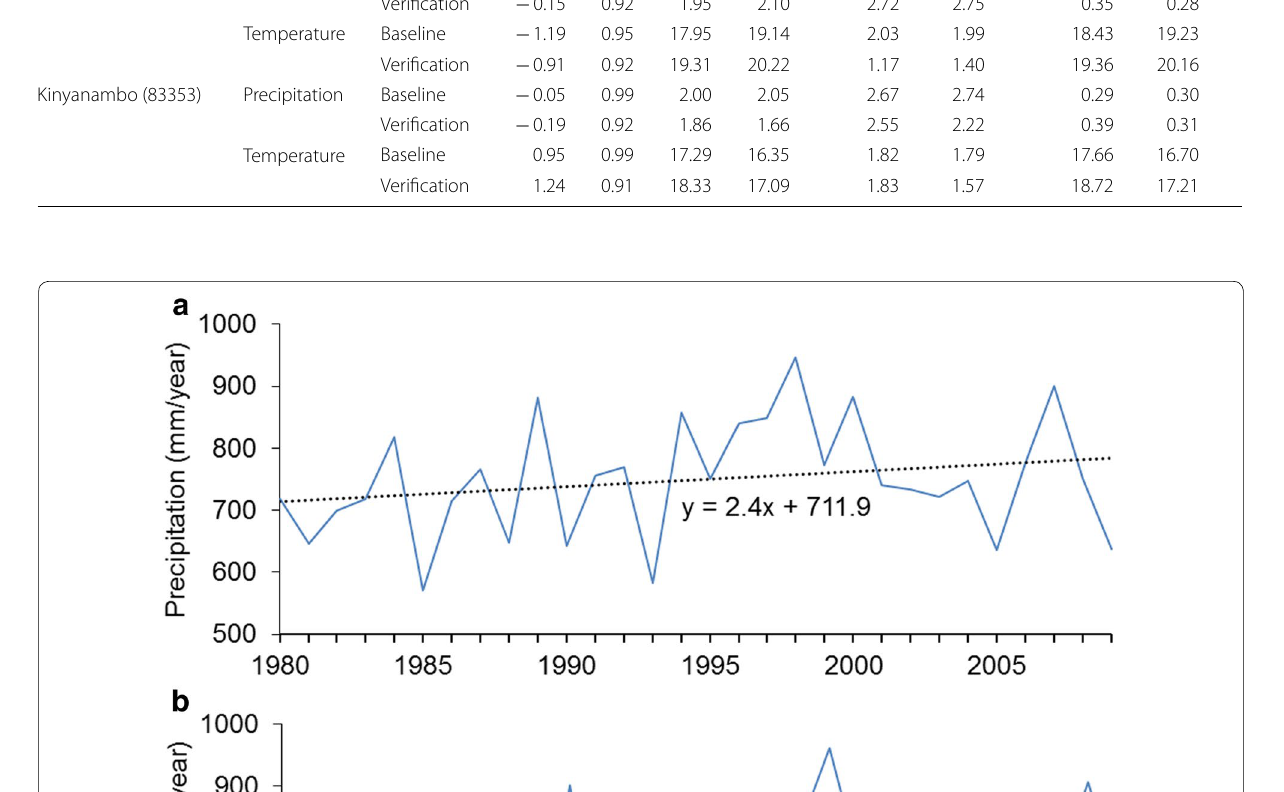
Fig. 14 Trend of annual mean precipitation amounts from 1980 to 2009 ( a ) and 2010 to 2039 ( b )